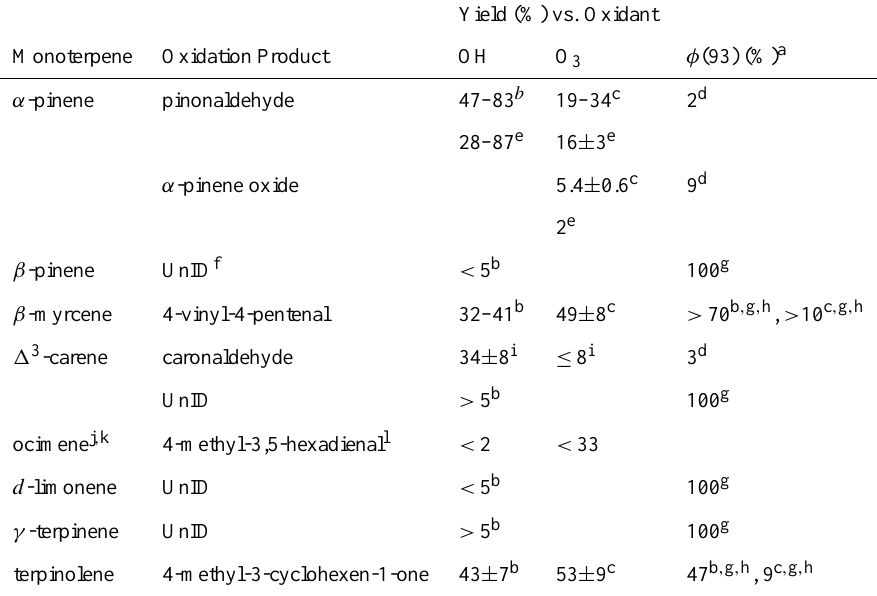
Table 7. Comparison of reported yields of m/z =93 fragment ions associated with analysis of monoterpene oxidation products by PTR-MS and